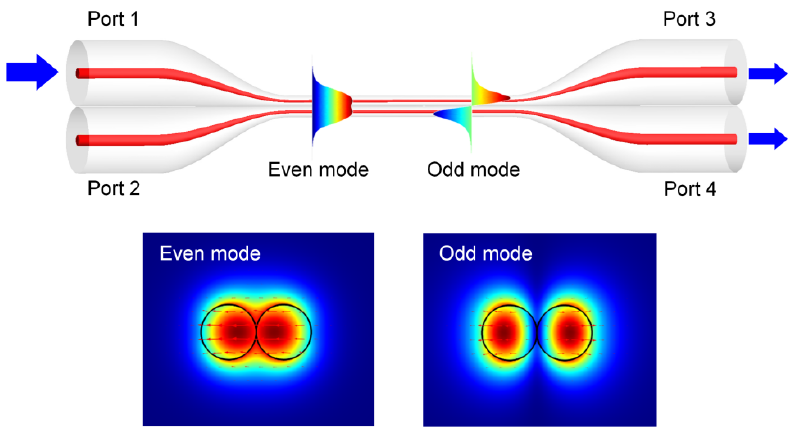
Figure 2. Schematic diagram of the nanofiber coupler and the modal field distributions for the even mode and odd